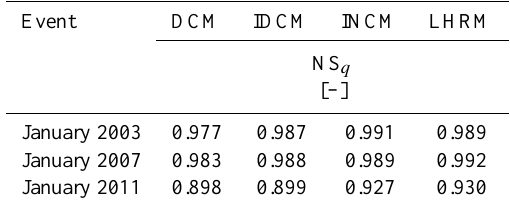
Table 6. Nash–Sutcliffe efficiency of estimated discharge hydro- graphs for the analysed flood